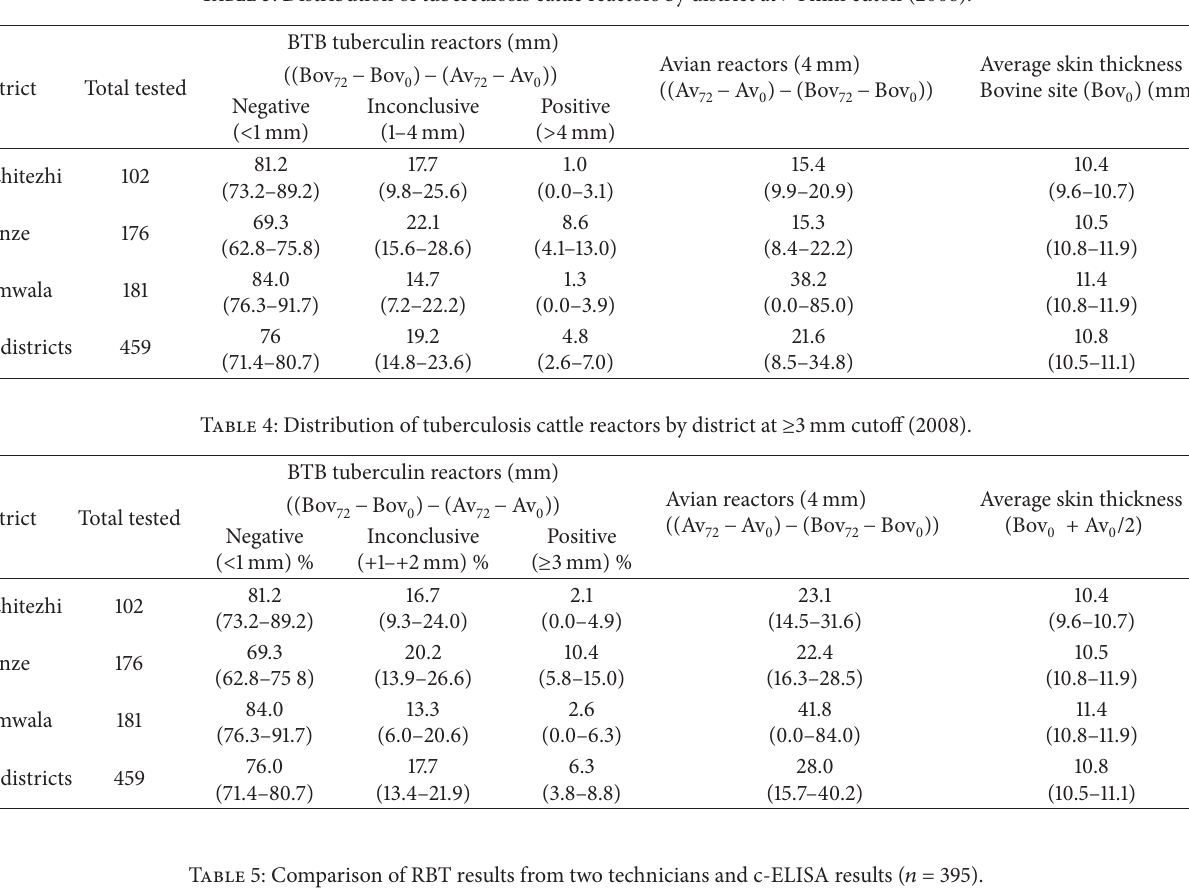
Table 3: Distribution of tuberculosis cattle reactors by district at > 4mm cutoff (2008).